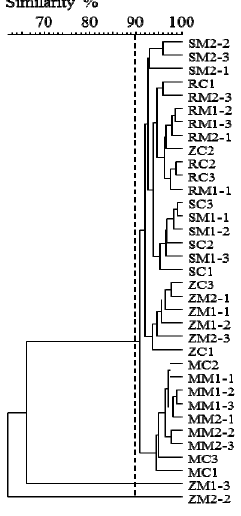
Figure 3. Unweighted pair group method with arithmetic mean (UPGMA) dendrogram of bacterial rhizosphere communities of moss-primed and untreated crop plants in two replicates (first number) with three repetitions per plant species (second number). The dendrograms were generated from SSCP community profiles using GelCompar II ® . The following settings were used: dendrogram type: UPGMA; similarity coefficient: curve-based Pearson correlation; optimization: 4%; position tolerance: 1%. The dashed line indicates a similarity level at 90%. Letter code: first letter of the bait plant species; M, maize; R, oilseed rape; S, sorghum; Z, sugar beet; the second letter is the treatment; M, moss; C,